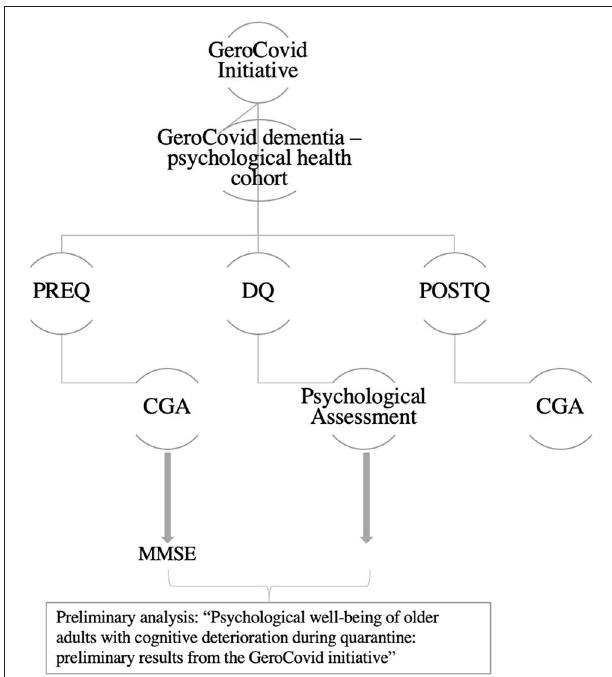
FIGURE 1 | Schematic representation of study design. PREQ, evaluation before quarantine; DQ, evaluation during quarantine; POSTQ, evaluation after quarantine; CGA, comprehensive geriatric assessment; MMSE, Mini Mental State